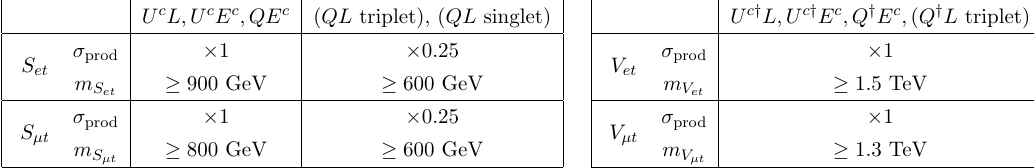
Table 8 . 95% CL lower limits on the mass of MLQs which decay into ( et )( et ) or ( (cid:22)t )( (cid:22)t ) (cid:12)nal states for the scalar leptoquarks ( left ) and the vector leptoquarks ( right ) from recasting the CMS SUSY search